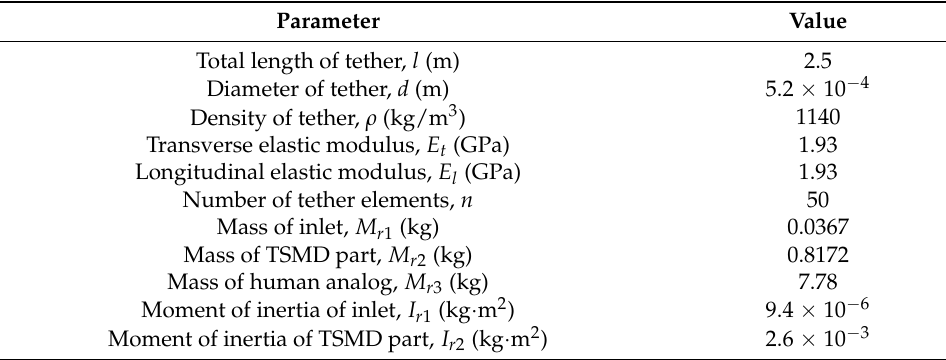
Figure 9. Diagram of initial conditions. Table 2. Calculation parameters.